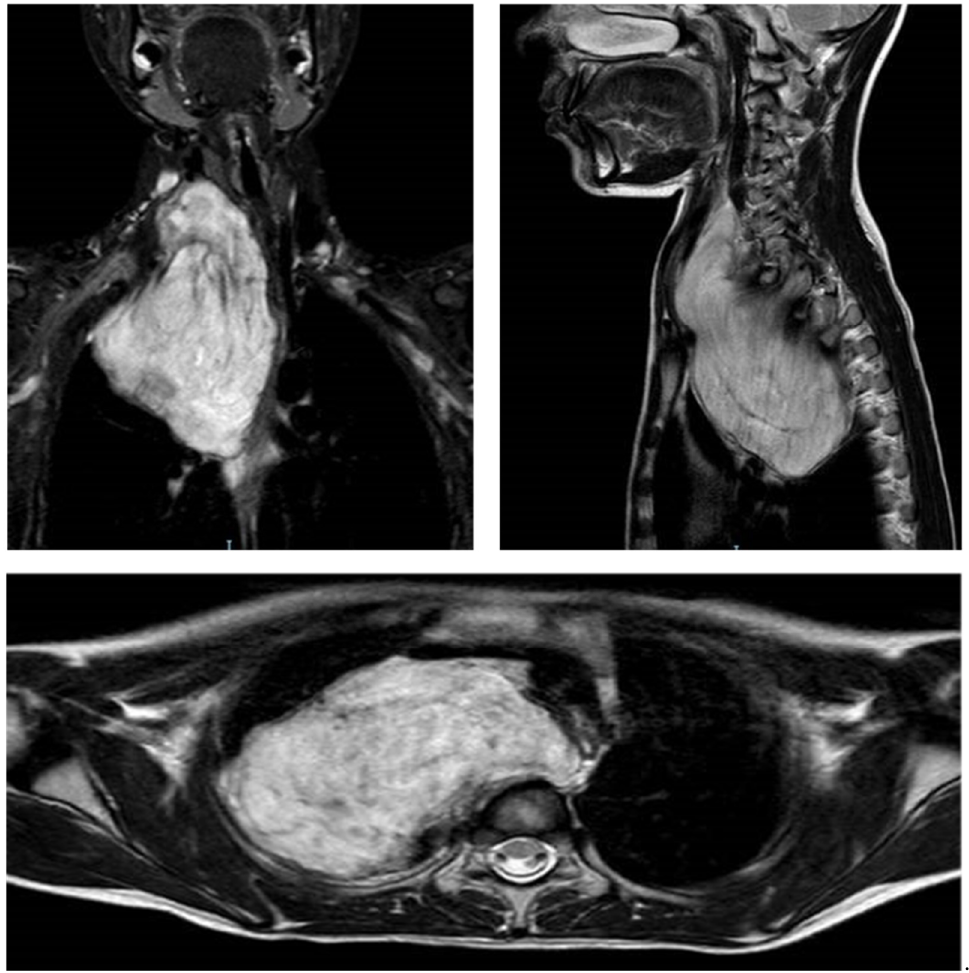
Figure 1. MRI scans of a patient affected by a cervicothoracic NB treated with CPT type B. The tumour causes the antero-lateral dislocation of the internal jugular vein, the right carotid artery, the trachea, and the bronchial biforcation. Posteriorly it penetrates into the epidural space (T1–T3), without compressing it. Inferiorly it extends toward the interscalen space along the brachial plexus. The subclavian and vertebral artery are in strict contact but not infiltrated by the tumour.